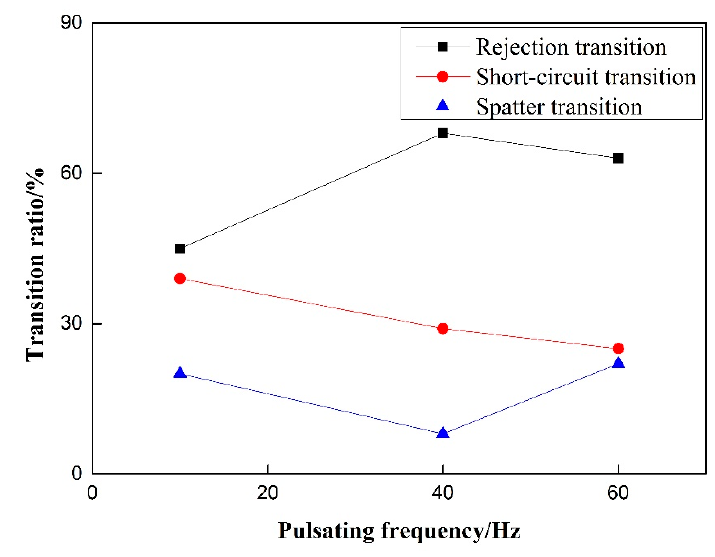
Figure 8. E ff ect of pulsating feeding frequency on transition ratio. Figure 8. Effect of pulsating feeding frequency on transition ratio.